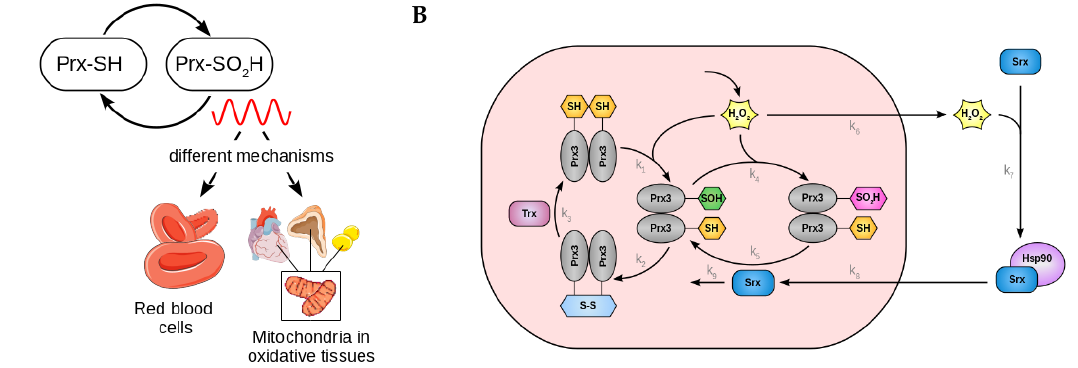
Figure 1. Peroxiredoxin (Prx) oxidation cycles occur with circadian periodicity in all kingdoms of life. ( A ) The mechanisms for 24h rhythm generation in Prx hyperoxidation in mammals differ in different cell types. ( B ) Model for the mechanism underlying circadian oscillation of Prx3-SO 2 H and sulfiredoxin (Srx) levels in mitochondria of adrenal gland, heart, and brown adipose tissue. See text for